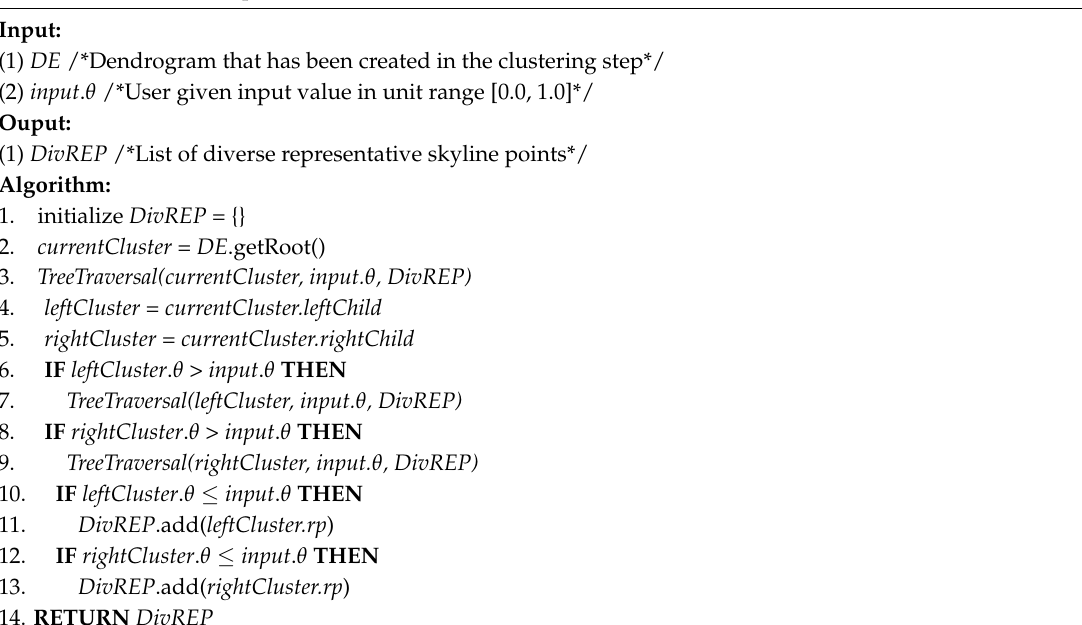
Algorithm 3. Diverse Representative